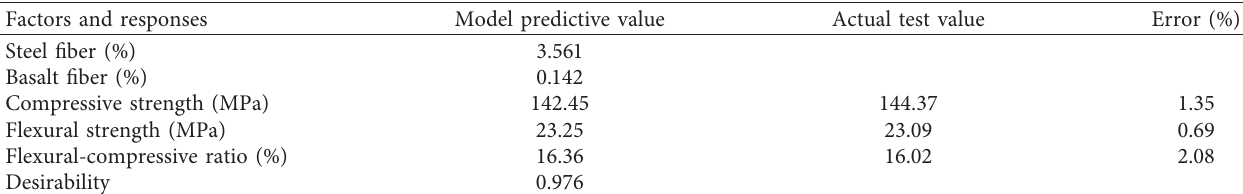
Table 15: Results of theoretical responses and additional experimental responses of optimal mix